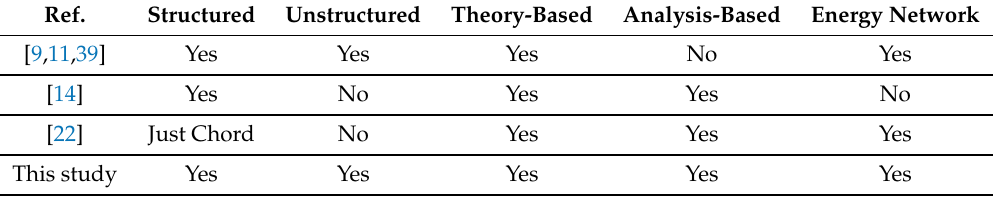
Table 1. Review on P2P Architecture for Energy Network. P2P: peer-to-peer.